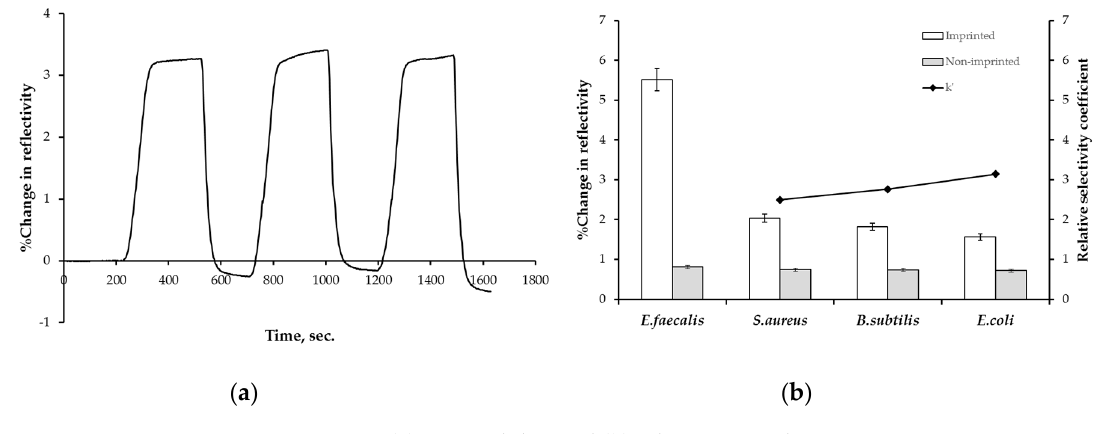
Figure 7. ( a ) Repeatability and ( b ) selectivity results.